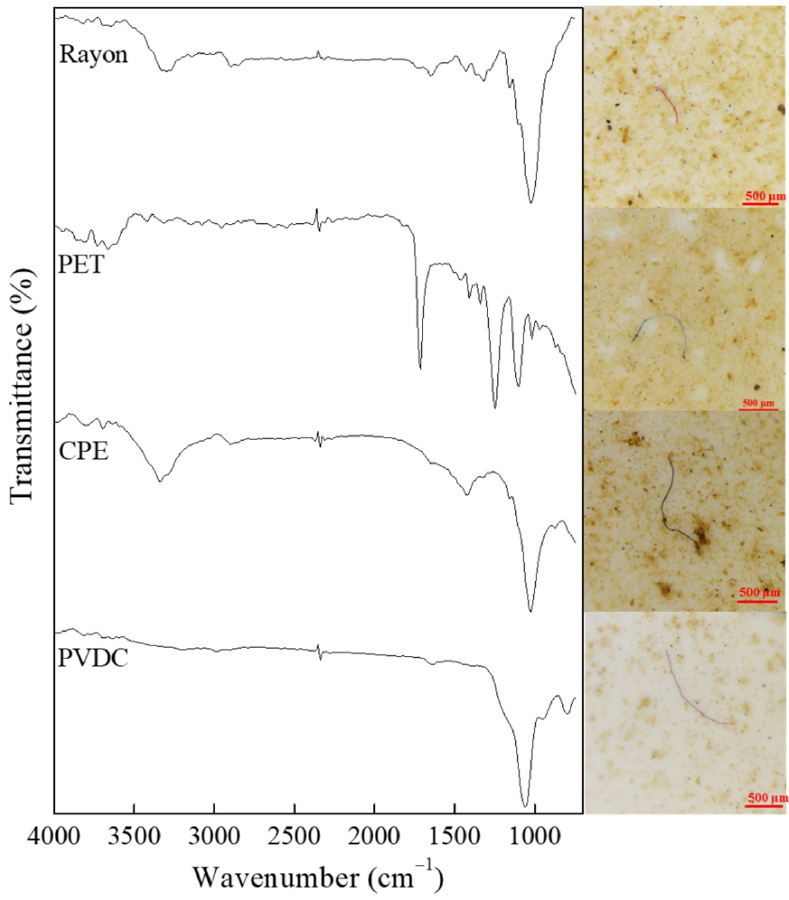
Figure 2. The µ - FT-IR spectra of major MP polymers (Rayon, PET, CPE, and PVDC) found in the effluents from WWTPs ( left ). Typical morphotypes of MP particles observed in the effluents from WWTPs in Qingdao ( right ).